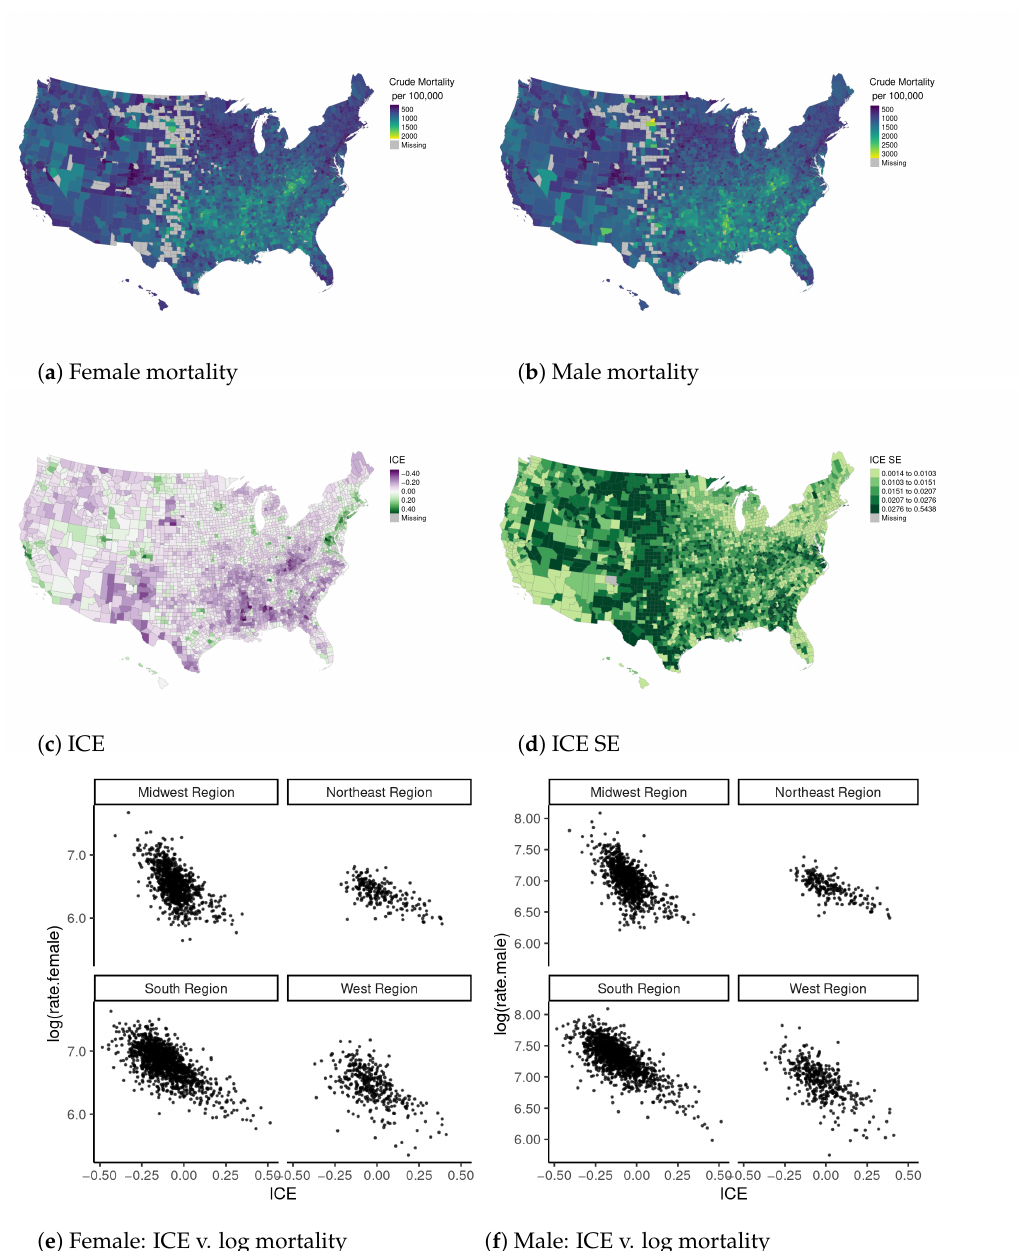
Figure 7. Raw U.S. county all-cause mortality rates by sex for ages 55–64, ICE estimates and their SEs, and scatter plots relating the ICE to the natural logarithm of the mortality rates by Census region.